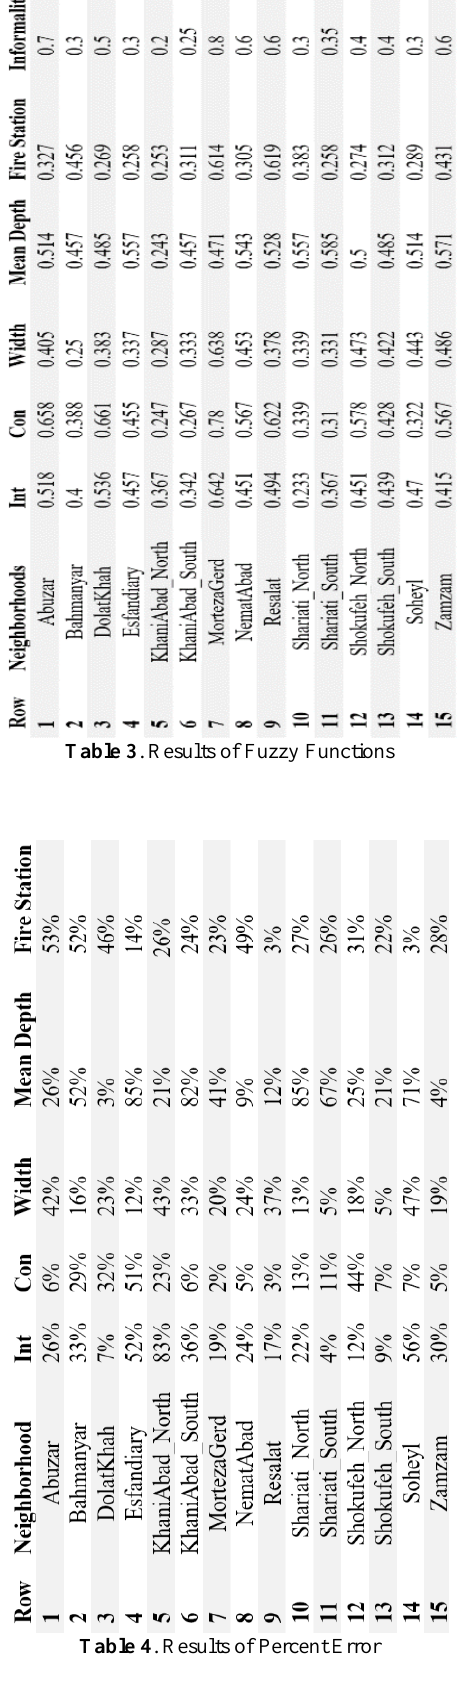
Table 2 . Results of Measurements